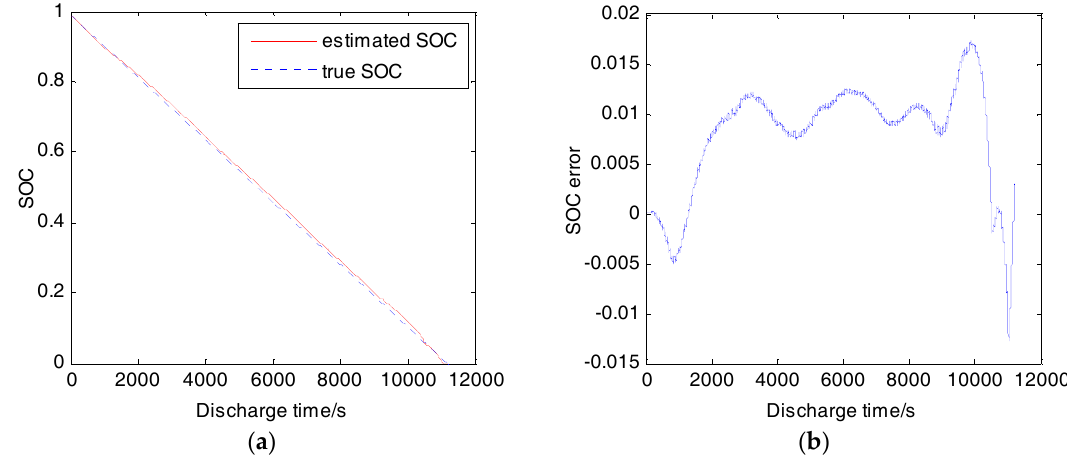
Figure 10. SOC estimation result (25 °C, 1/3 C): ( a ) Estimated SOC and true SOC; ( b ) SOC estimation error.